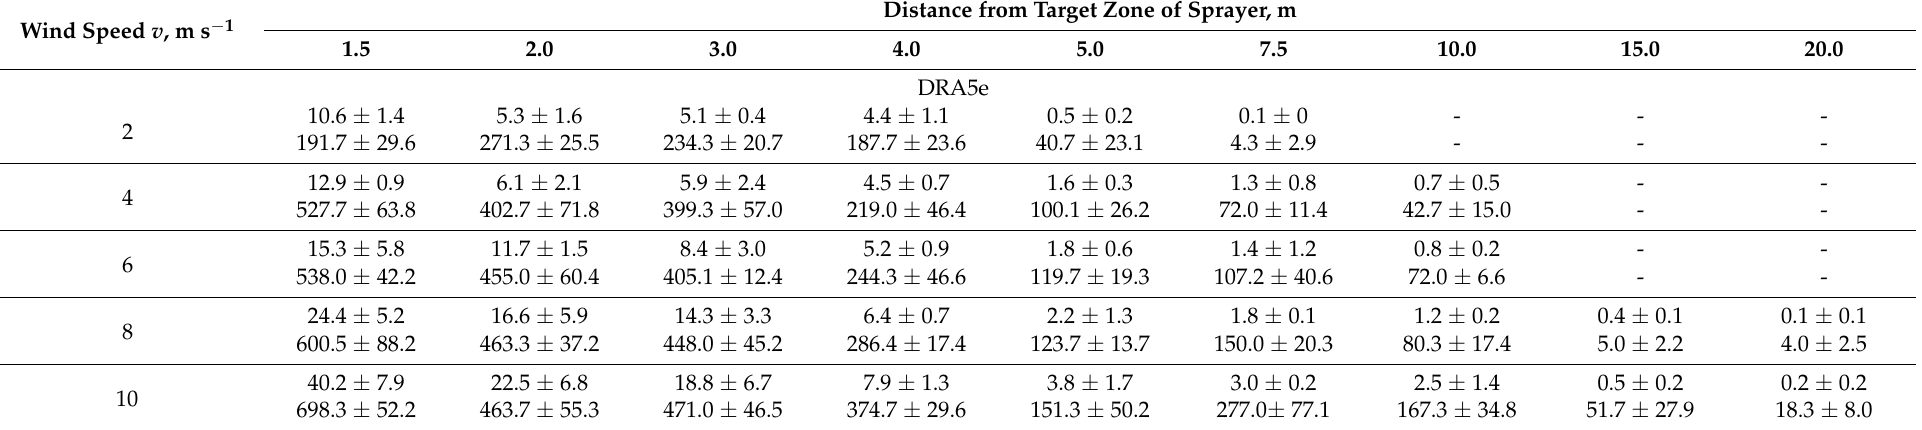
Table 6. Water-sensitive paper coverage (upper line, %) and number of droplets (lower line) for five standard flat spray nozzles on a sprayer, depending on the target zone of the